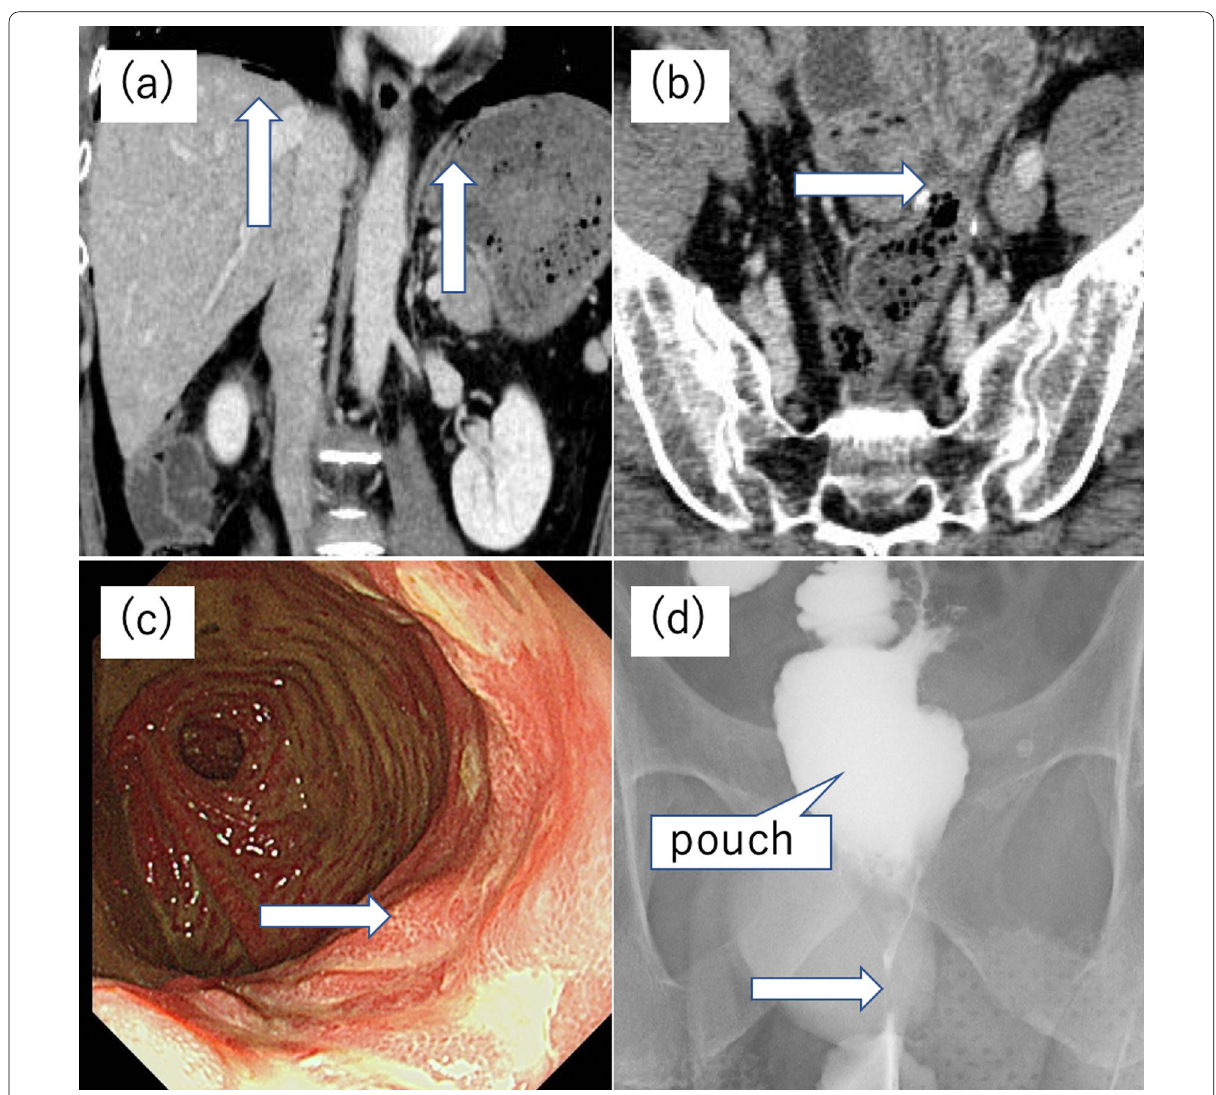
Fig. 3 Findings upon the second perforation. a , b Contrast-enhanced computed tomography. Contrast-enhanced CT revealed free air (arrow: a ) and fluid collection around the blind end of the J-pouch (arrow: b ). c Endoscopic observation and gastrointestinal gastrography findings after surgery. Endoscopy revealed multiple ulcers in the ileal J-pouch, and gastrointestinal gastrography revealed an anastomotic stricture. d Gastrointestinal gastrographic findings after surgery. Gastrointestinal gastrography revealed an anastomotic stricture